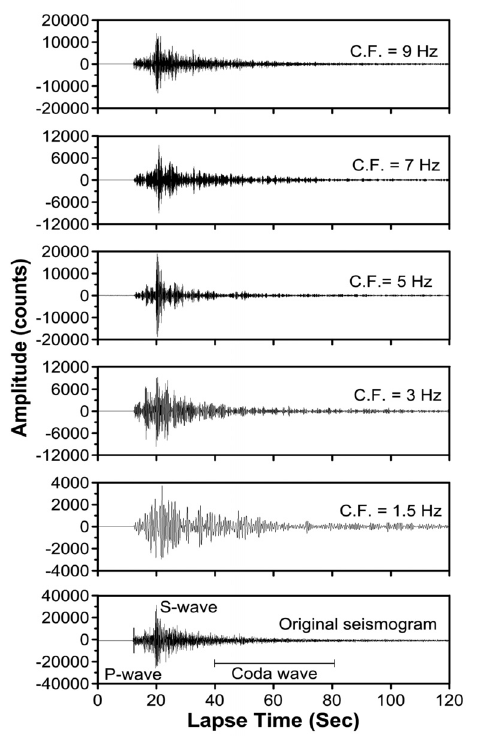
Figure 2. A sample of original and filtered seismogram at different frequency bands for SONA station recorded on June 7, 2006.